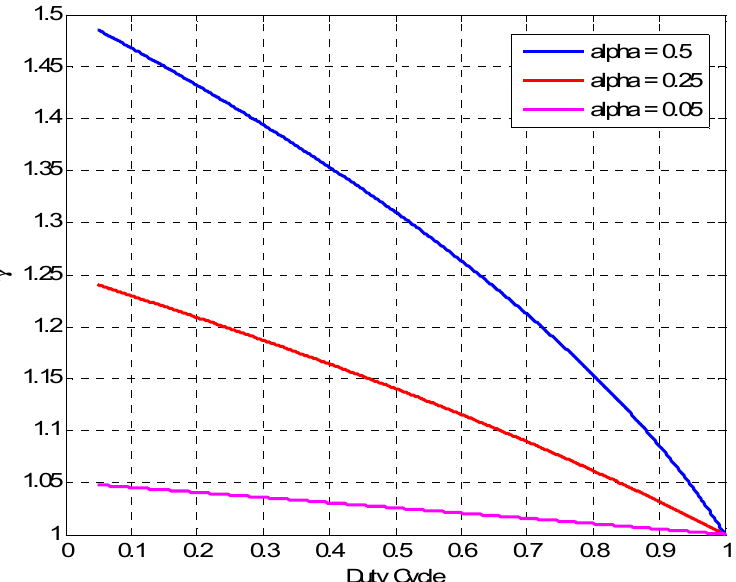
Figure 15. CCF versus duty cycle for different values of BSF .